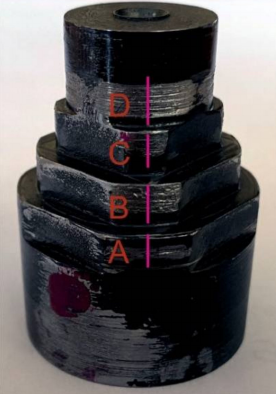
Figure 14. The sample worn initially DLC covered surfaces of steel shaft shoulders after the mating with the front planes of steel plunger fins. A, B, C, D—the worn cylindrical surfaces of the consecutive shaft shoulders.